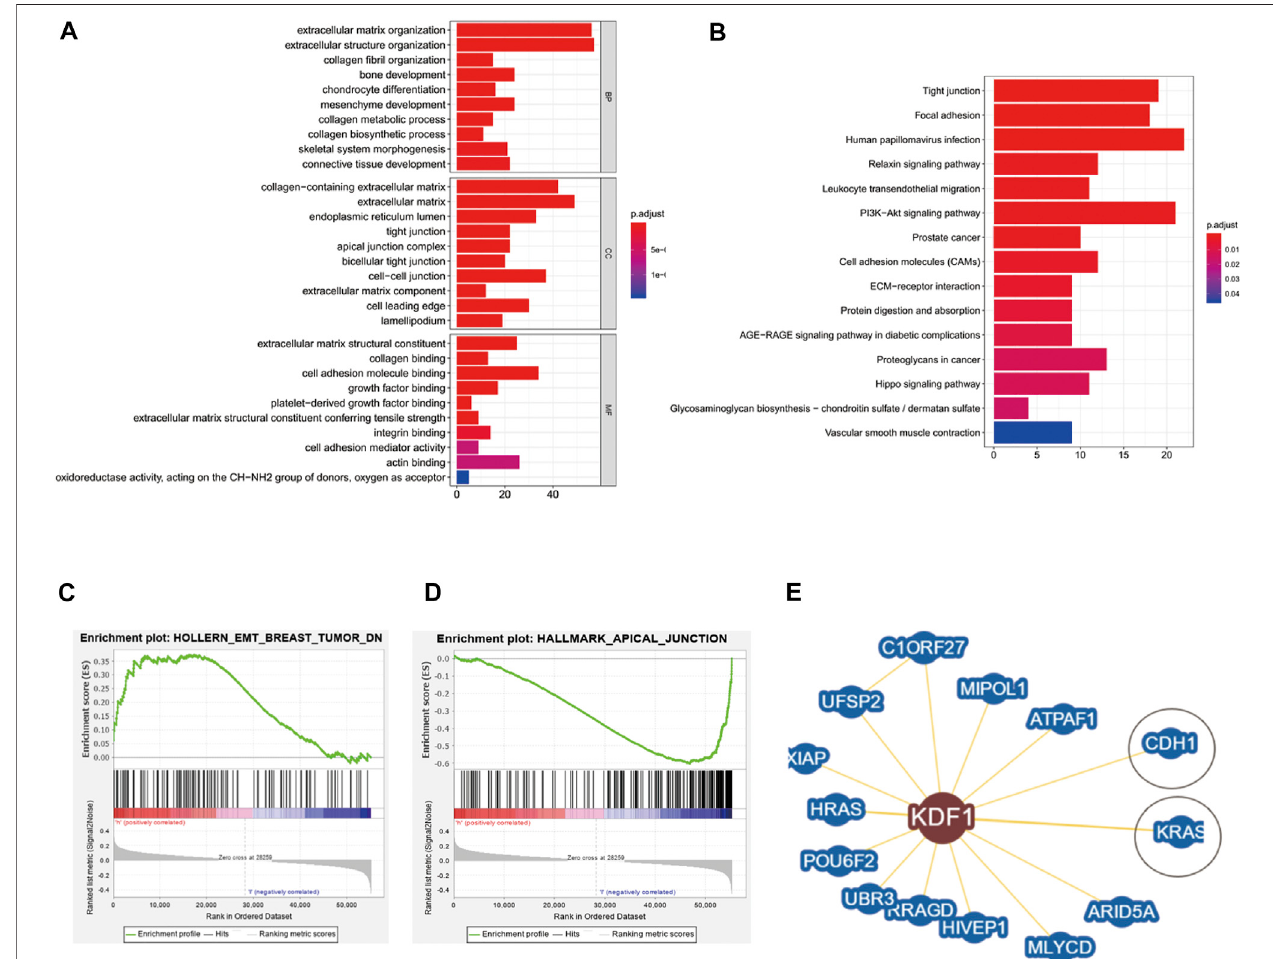
FIGURE2| Result ofenrichmentanalysisand protein – protein interactionanalysisofKDF1 inovarian cancer. Theresult ofenrichmentanalysisfrom GO (A) ,KEGG (B) , and GSEA (C) . The KDF1 interacting protein was predicted by Biogrid (D) .